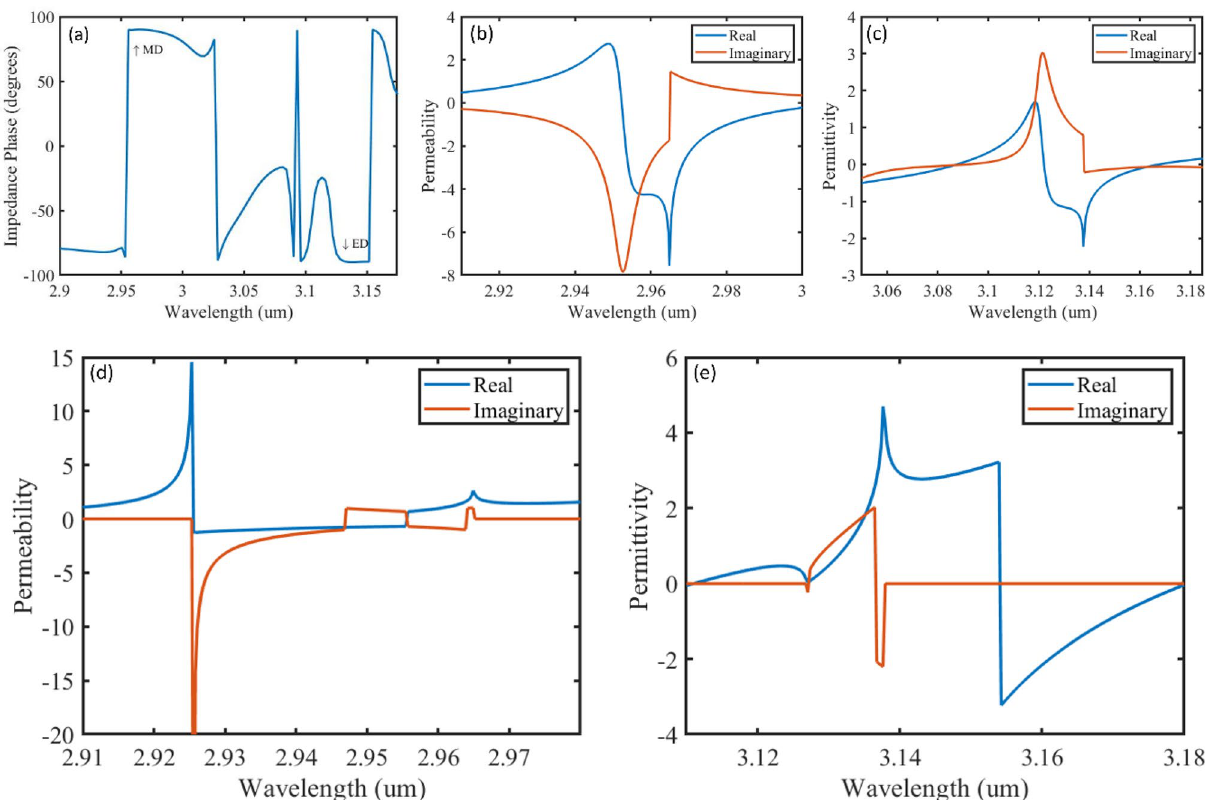
Figure 3. Dispersion parameters for positive propagation: ( a ) impedance phase ( b ) effective permeability ( c ) effective permittivity, and dispersion parameters calculated from averaged s-parameters: ( d ) effective permeability ( e ) effective permittivity.